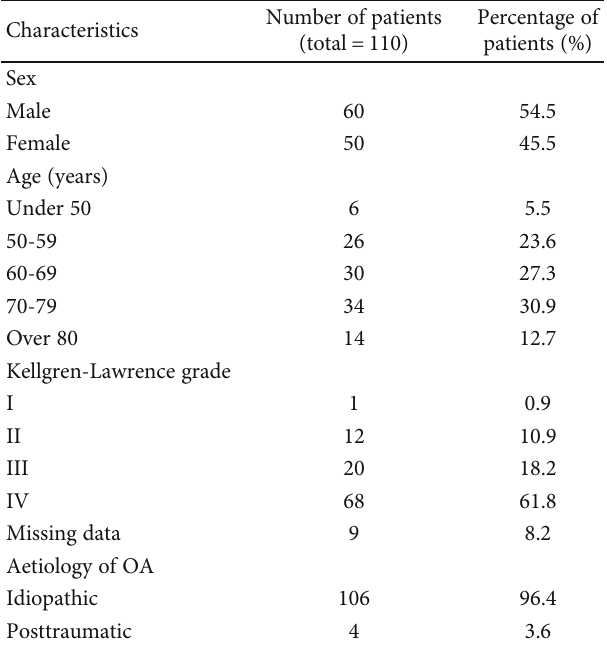
Table 2: Patients ’